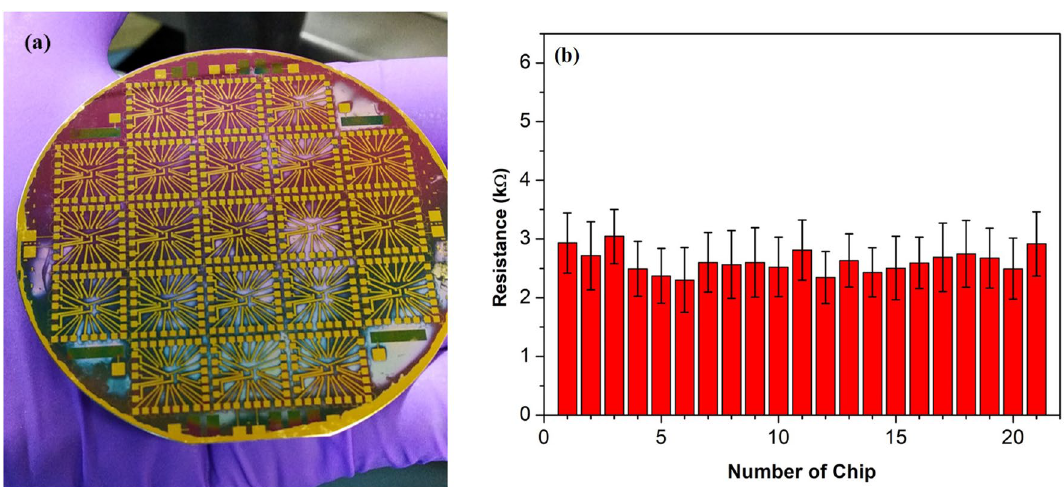
Figure 5. ( a ) Photograph of a 3-in. silicon wafer with 21 chips of LG-CNTFET array, and ( b ) bar-chart of average resistance of individual chips of the fabricated devices with the deposited s-SWNTs network, shows the uniformity among 21 chips of the 3-in.